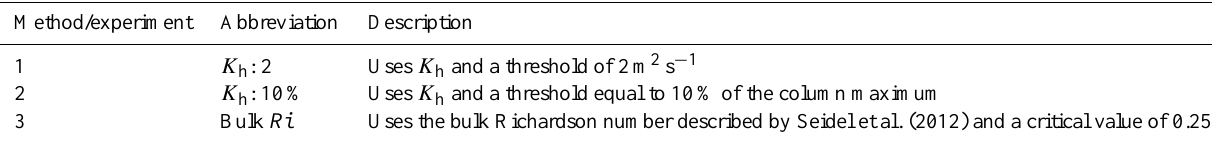
Table 1. Summary of PBL depth